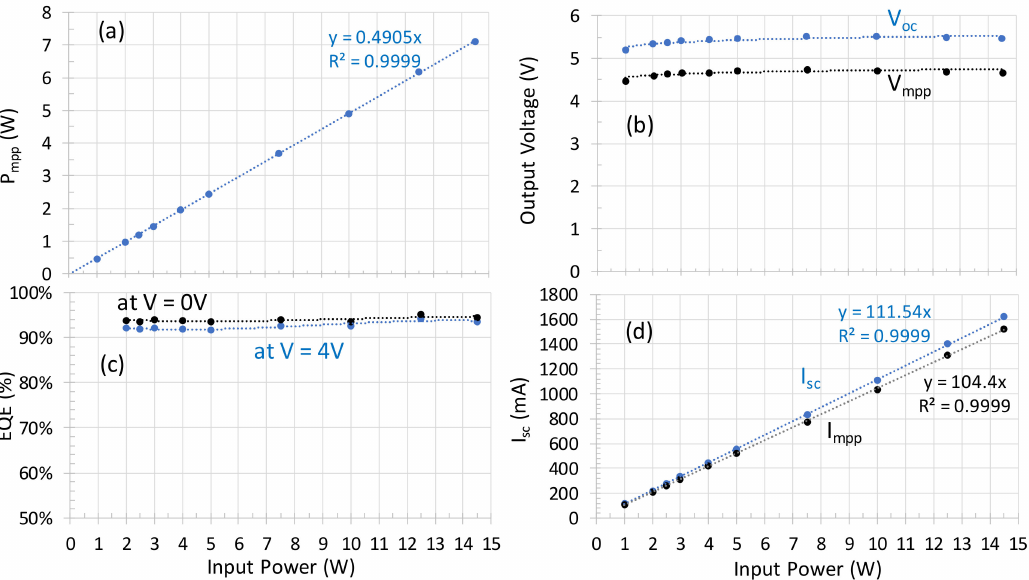
Figure 4. The PT10-InGaAs/InP’s input power dependence with an incident laser beam peaking at 1466 nm at 21 ◦ C. The electrical output power, P mpp , is shown in ( a ), the output voltage: open-circuit voltage (V oc ) and maximum power point voltage (V mpp ) are shown in ( b ), the external quantum efficiency (EQE) is shown in ( c ), and the output current, short-circuit current (I sc ) and maximum power point current (I mpp ), are shown in ( d ). The values of the linear regressions are indicated in the